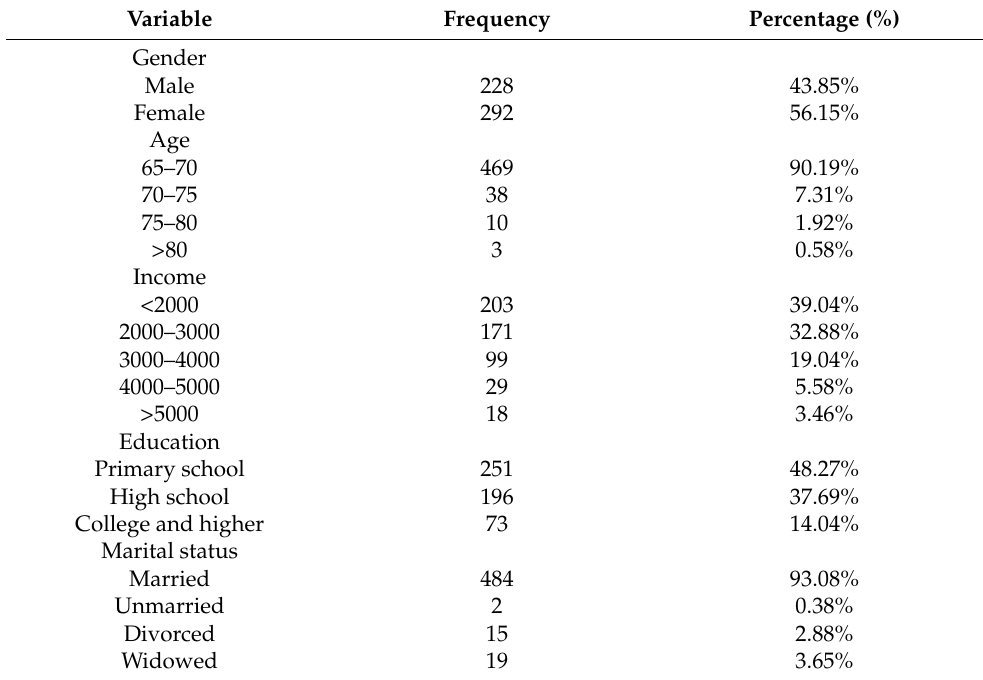
Table 1. Demographic characteristics of the